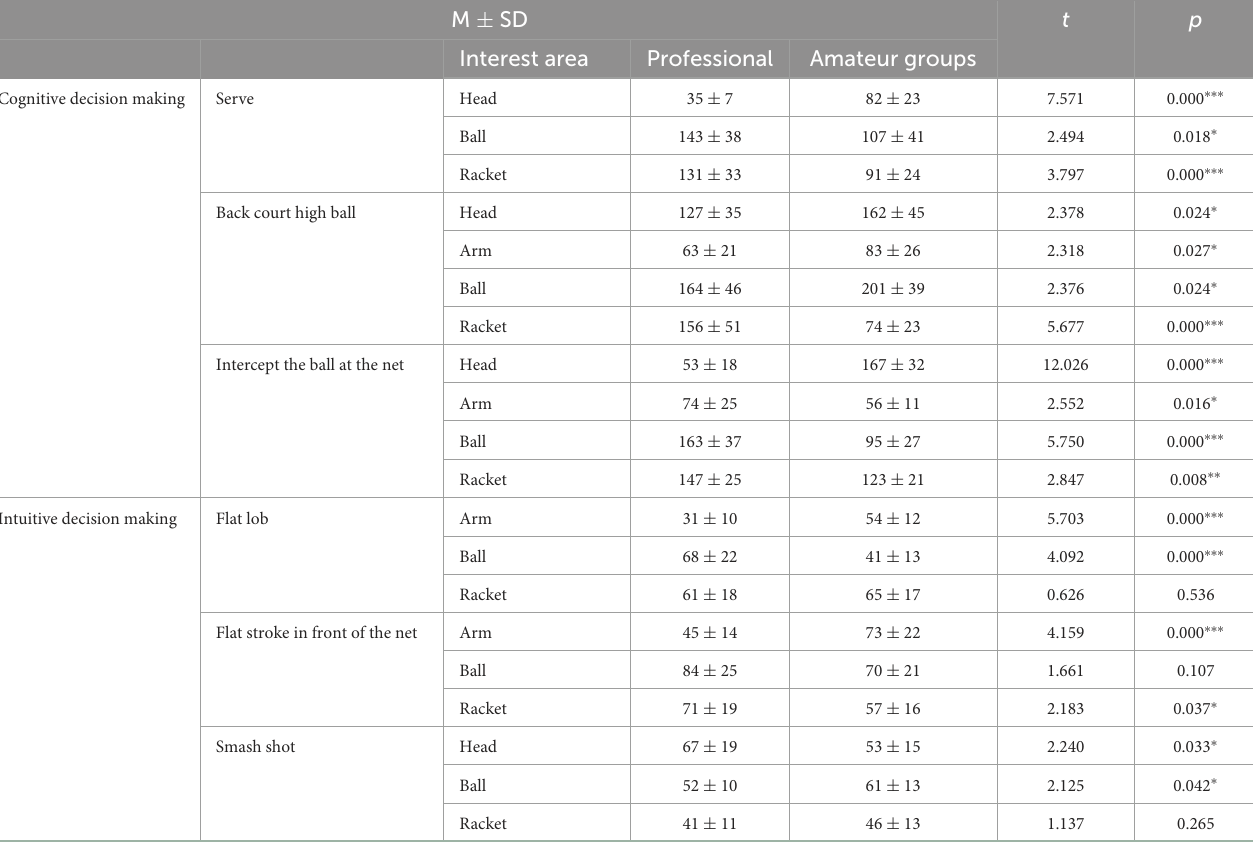
TABLE 6 A comparison of the fixation frequency of the two groups of different areas of interest subject area monitoring frequency test results between the two groups (unit: times).